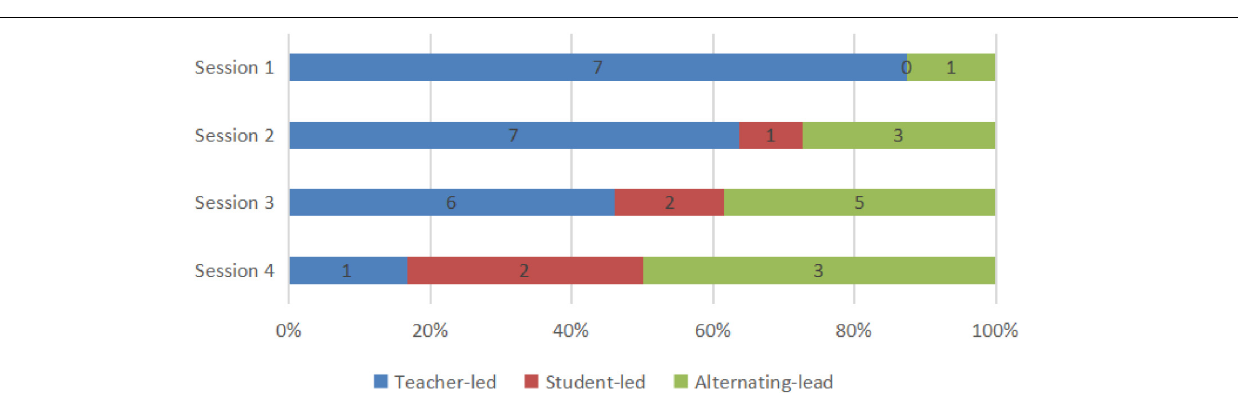
FIGURE 3 | The sum of time periods for different kinds of